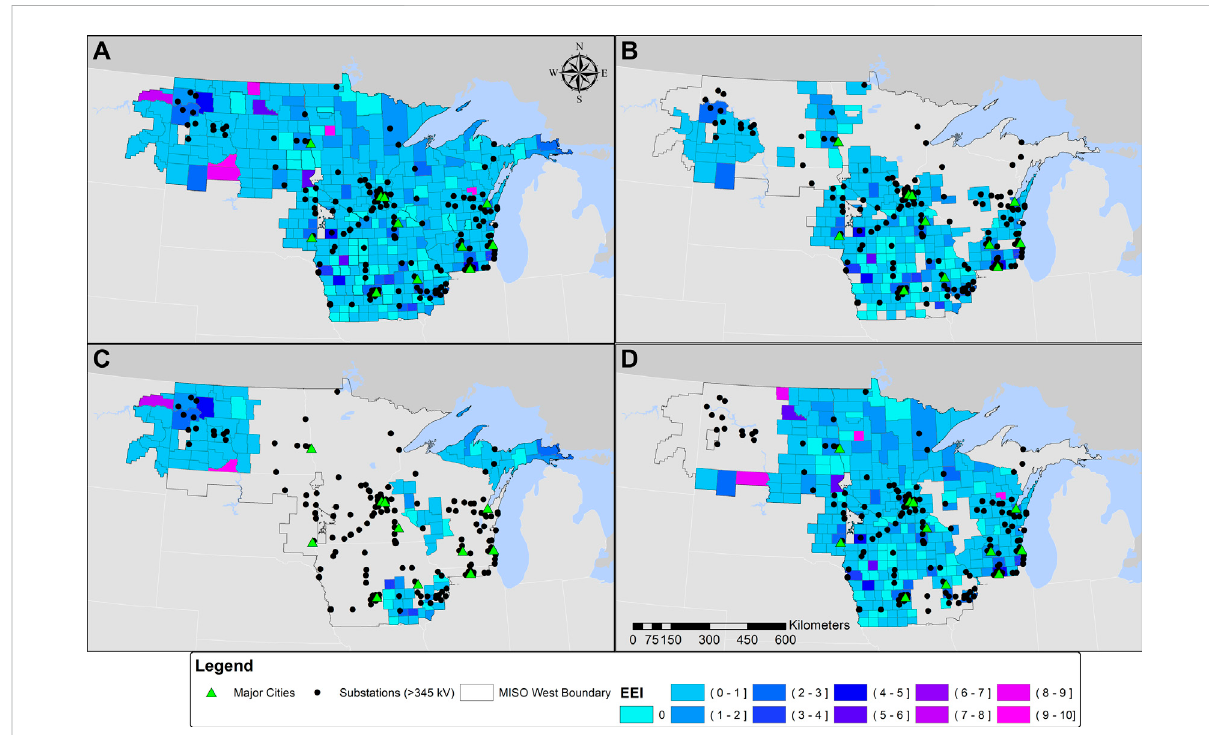
FIGURE 4 Energy equity index, EEI, by county for (A) all counties, (B) counties with low-impact wind per Site Renewables Right, (C) counties that are historic fossil fuel communities, and (D) counties that are not historic fossil fuel communities. For EEI ranges, parenthesis indicate exclusive, and brackets indicate inclusive.